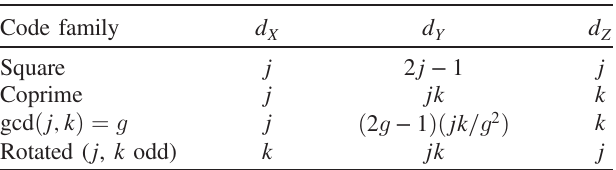
TABLE I. Distances to pure noise for j × k surface code families. ( d refers to the distance to pure P noise, where P P ∈ f X; Y; Z g .)